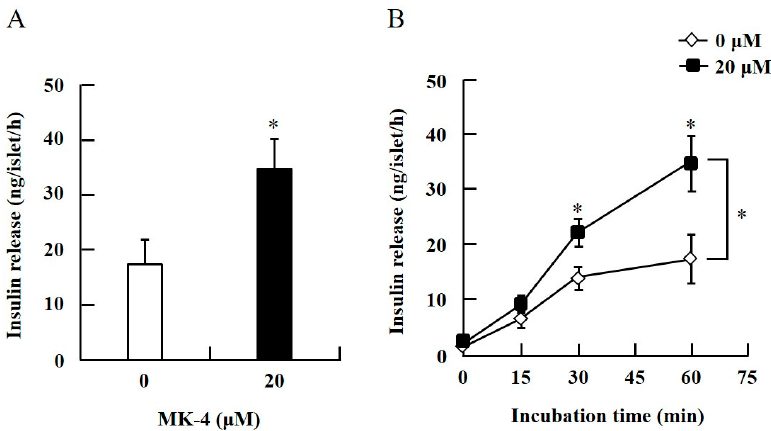
Figure 1. MK-4 regulated GSIS in INS-1 cells. Cells were treated with the indicated concentrations of glucose and MK-4 for 1 h. Data are presented as mean ± SD ( n = 3); * p < 0.05, ** p < 0.01.